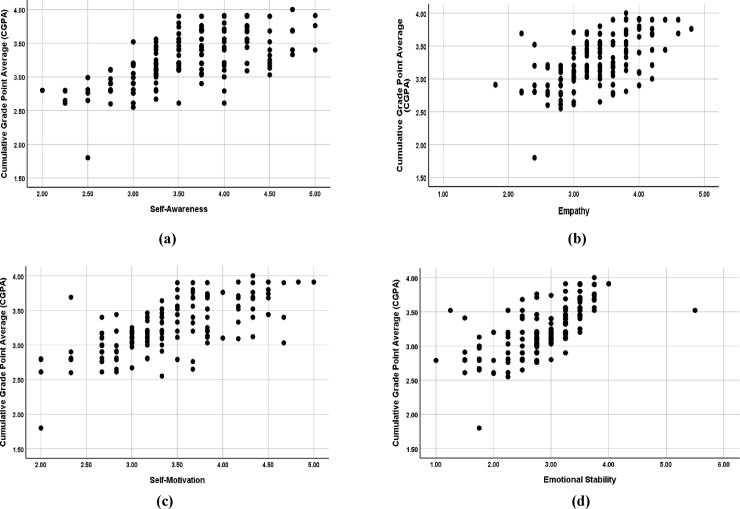
Correlation between the subdimensions of emotional intelligence and academic success.The scatterplots (a-d) clearly indicate the significant positive relationships among Self-awareness & CGPA; Empathy & CGPA; Self-Motivation & CGPA; and Emotional Stability & CGPA.